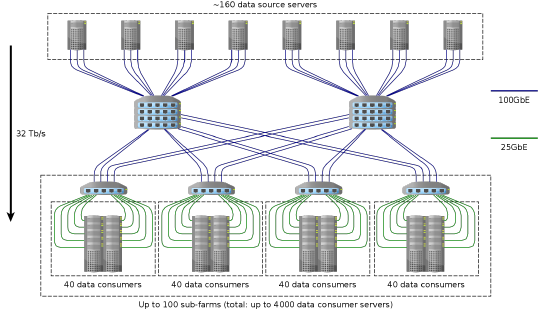
Figure 1. RoCE v2 Ethernet-based LHCb event